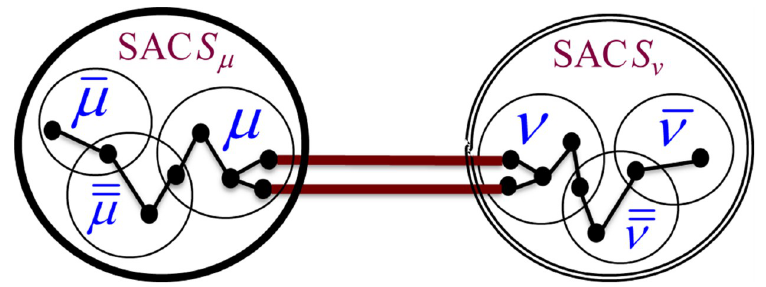
Fig 5. Generic notations used for constructing the formula in Eq 1 for computing the BI ( u , v ) of an Association Edge ( μ , ν ). The figure depicts a generic pair of communicating MKCSSs � m and � n that belong to SACs S respectively, whose messages pass through ( μ , ν